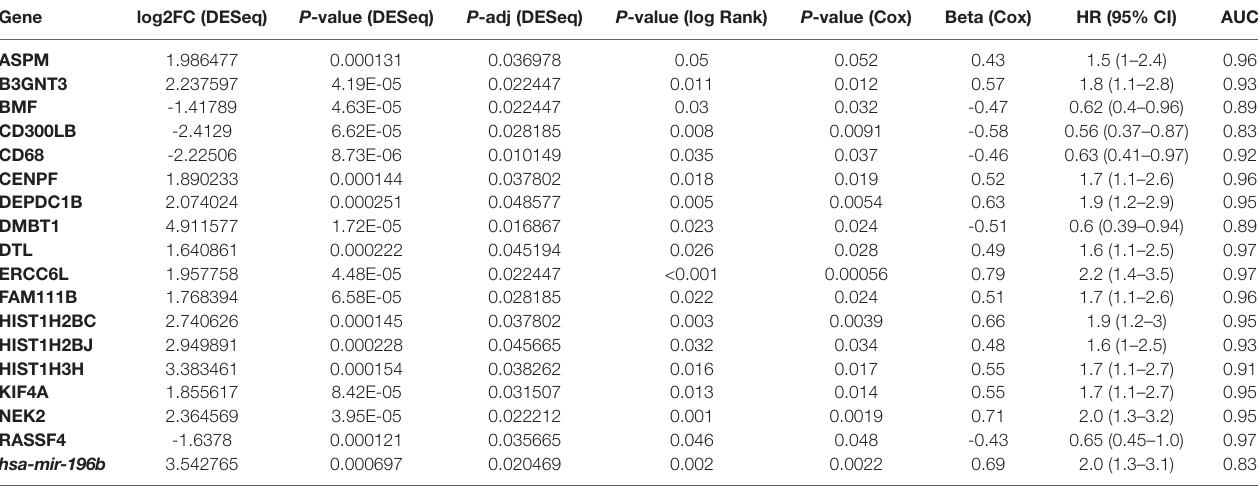
TABLE 4 | List of probable prognostic gene/miRNA biomarkers for pancreatic ductal adenocarcinoma. List of genes and miRNA which have very low p -value in survival and DESeq2 differential gene expression analysis, and high area under curve (AUC). Gene log2FC (DESeq) P -value (DESeq) P -adj (DESeq) ASPM